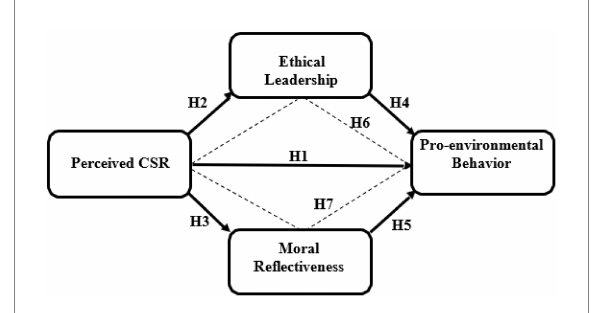
FIGURE 1 Presents the conceptual framework of this study. * Straight lines show the direct effects. ** Dotted lines show the indirect